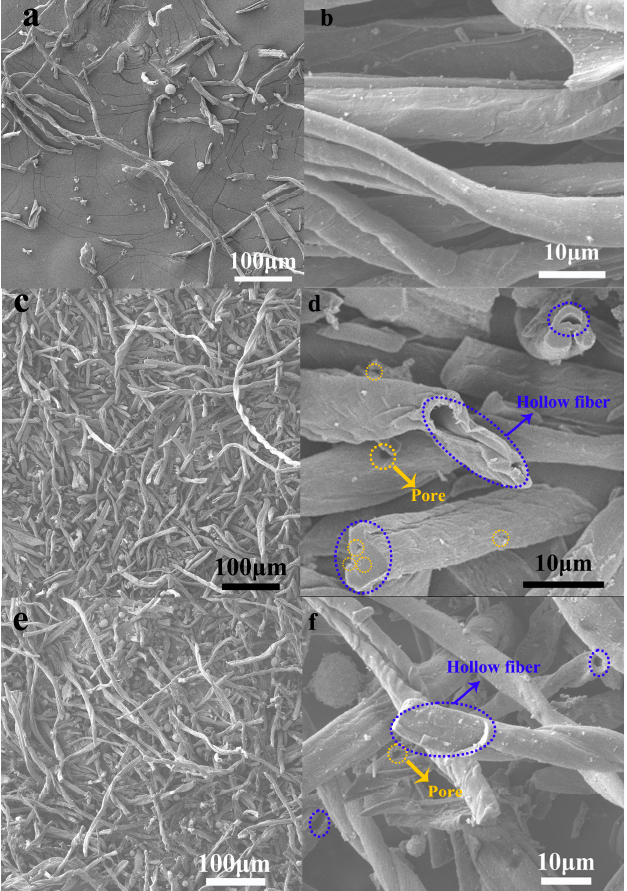
Figure 2. The scanning electron microscope (SEM) images of CCT ( a , b ); CCT-BFO ( c , d ) and CT-BFO ( e , f ) respective.